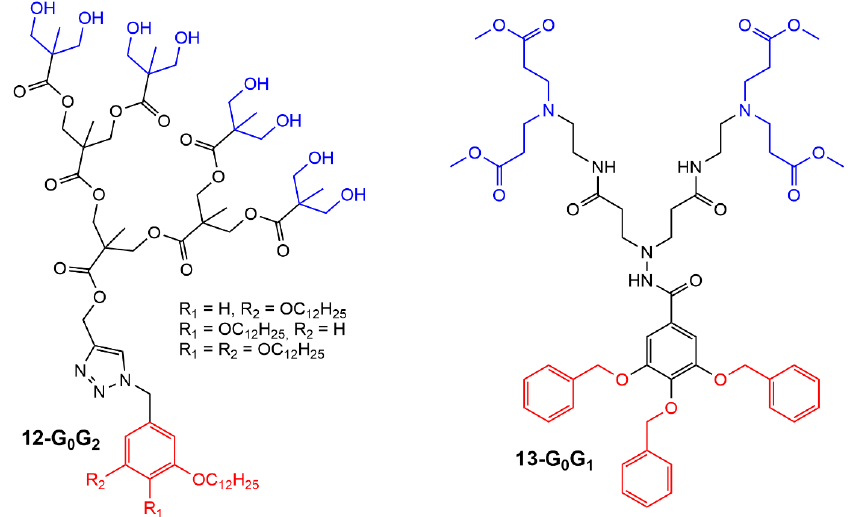
Figure 10. Structure of small amphiphilic Janus dendrimers suitable for affording hydrogels.